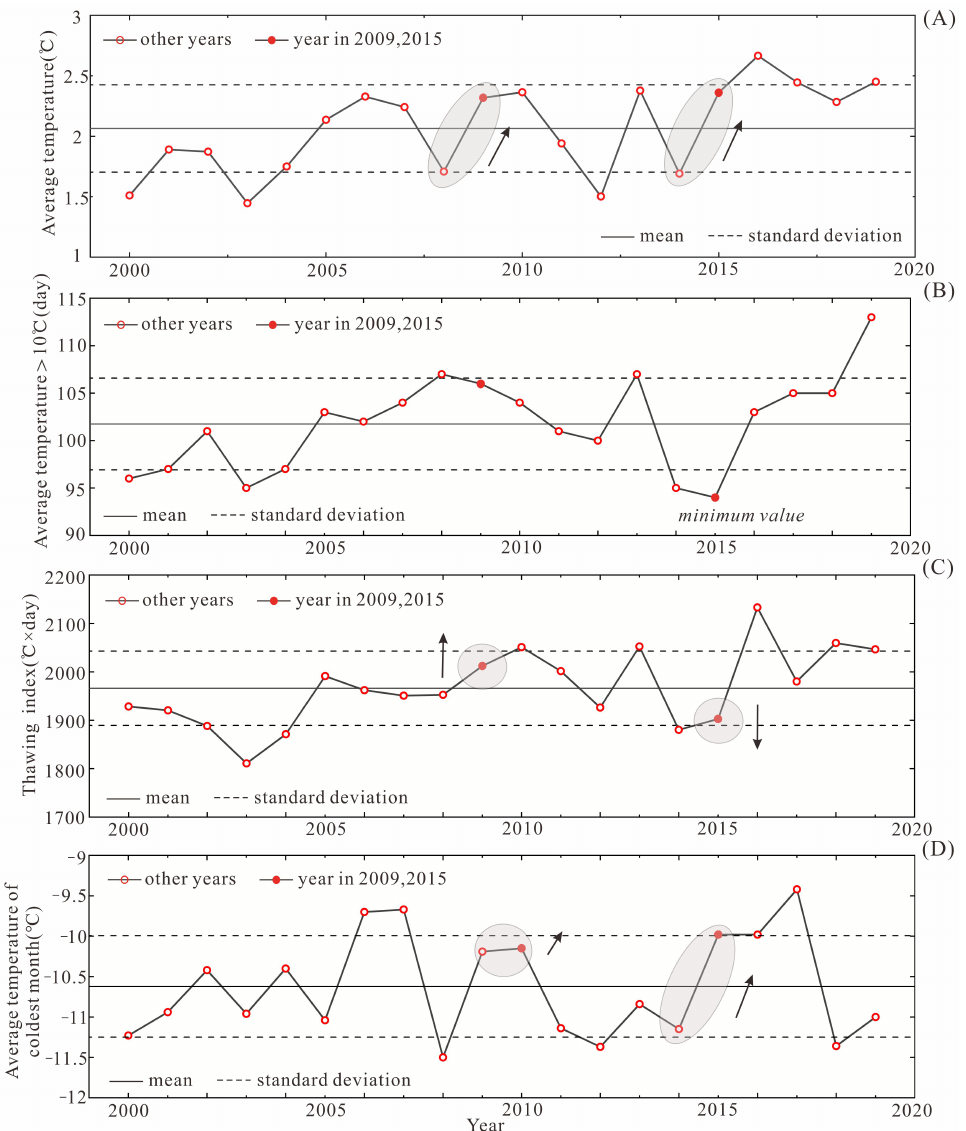
Figure 8. Variations in air temperature during 2000–2019: ( A ) mean annual air temperature (MAAT), ( B ) warming days with an annual average temperature greater than 10 ◦ C, ( C ) thawing index, ( D ) average temperature of the coldest